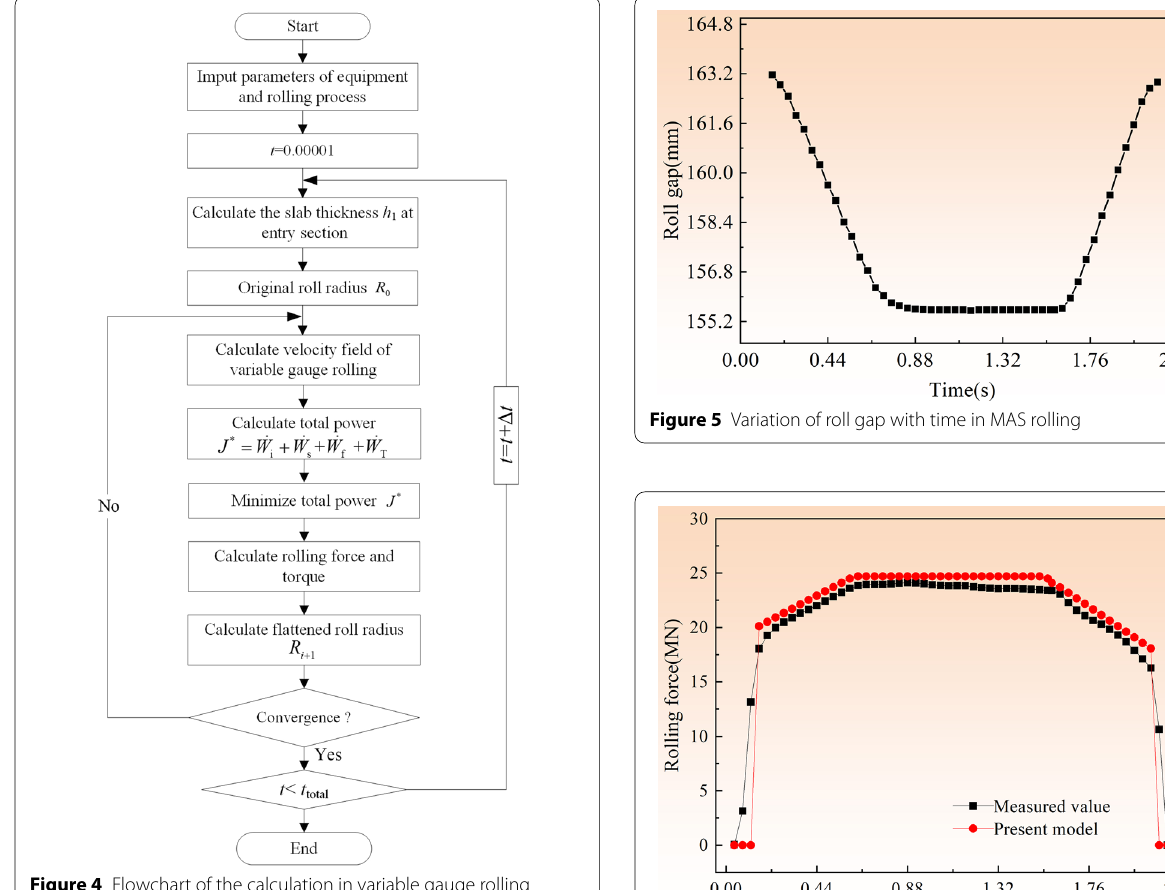
Figure 4 Flowchart of the calculation in variable gauge rolling